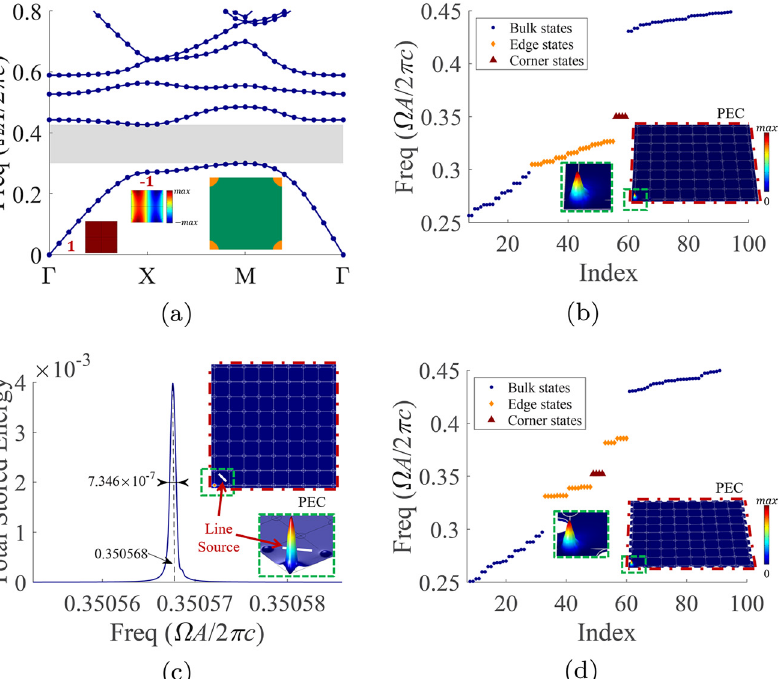
-symmetric gyromagnetic HOTI. (a) The unit cell and its band structure. The inserted diagrams and markers ‘‘ ± 1’’ Figure 3: The optimized C 4v displayed their parities at high-symmetry momenta; (b) the supercell’s spectrum and highly localized corner states with truncation, where the inserted red-triangle points reveal the corner states; (c) the spectrum of the stored energy of the corner states with the inserted diagrams illustrating the full-wave simulation result at the mid-frequency; (d) the spectrum and corner states of supercell after the perturbation about the cavity, denoted as a white semi-circle with radius 20 % A